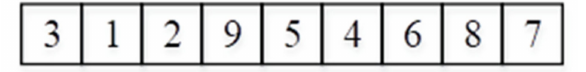
Figure 1. An example of permutation encoding in a 9 × 3